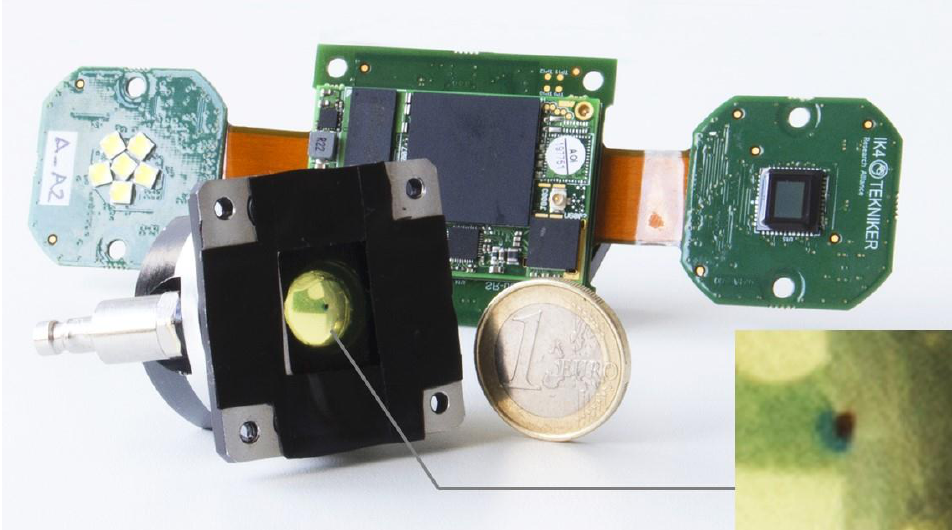
Figure 13. Sensor Prototype. The micromechanical sensor body is in the front, where the measurement cell is detailed. The electronic subsystem with the processor, the CMOS and the LED lighting is in the background.